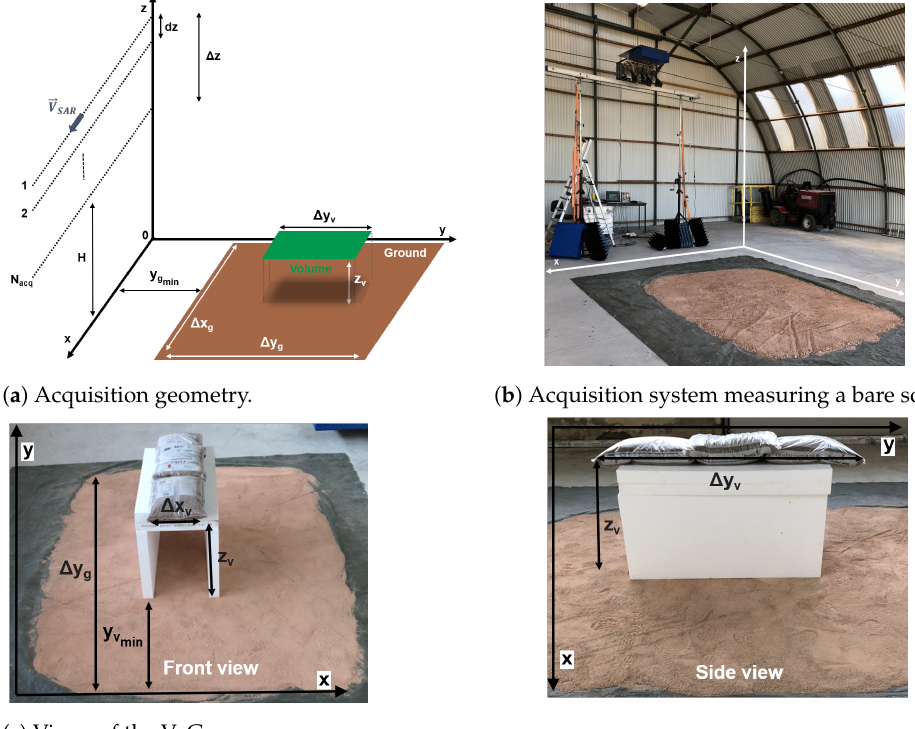
Figure 2. Illustration of the experimental setup.